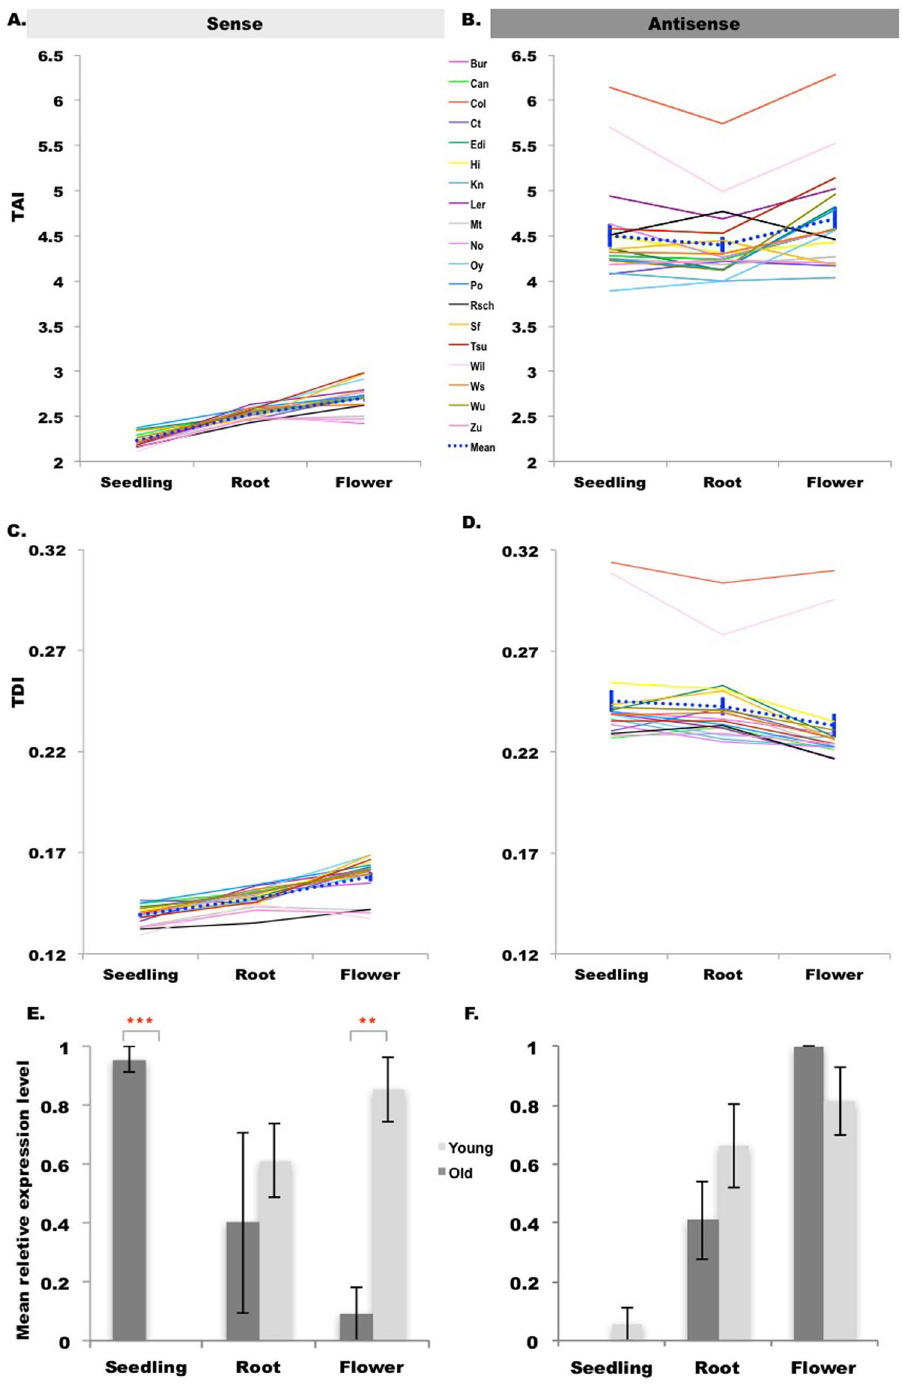
Figure 3. Transcriptome indices of seedling, root and flower across 19 A. thaliana accessions. ( A ) The sense transcriptome age index (TAI) profile of three organs across 19 accessions. ( B ) The antisense transcriptome age index (TAI) profile of three organs across 19 accessions. ( C ) The sense transcriptome divergence index (TDI) profile of three organs across 19 accessions. ( D ) The antisense transcriptome divergence index (TDI) profile of three organs across 19 accessions. The standard errors of TAI and TDI, estimated by bootstrap analysis (1000 replicates), are extremely small so that they cannot be seen in ( A – D ), but are presented in Tables S2, 4, 6, 8 and 10. The comparisons of TAI and TDI between any two organs are significant by the Mann Whitney test, and the p-values are presented in Tables S3, 5, 7, 9 and 11. ( E ) Mean relative sense expression levels of evolutionarily old (PS1–PS3) and young (PS4–PS12) genes in different organs in a representative accession: Ler- 0. ( F ) Mean relative antisense expression levels of evolutionarily old (PS1–PS3) and young (PS4–PS13) genes in different organs in Ler-0. The comparisons of relative antisense expression levels between old and young genes in different organs were performed by t test: *** means p-value < 0.001; ** means p-value < 0.01; * means p-value < 0.05; no * means not